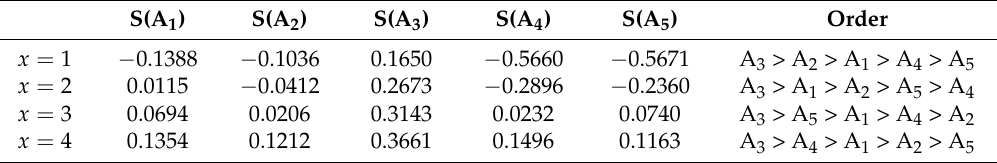
Table 6. The ordering results for the IVIFWDDHM operator with different parameters.